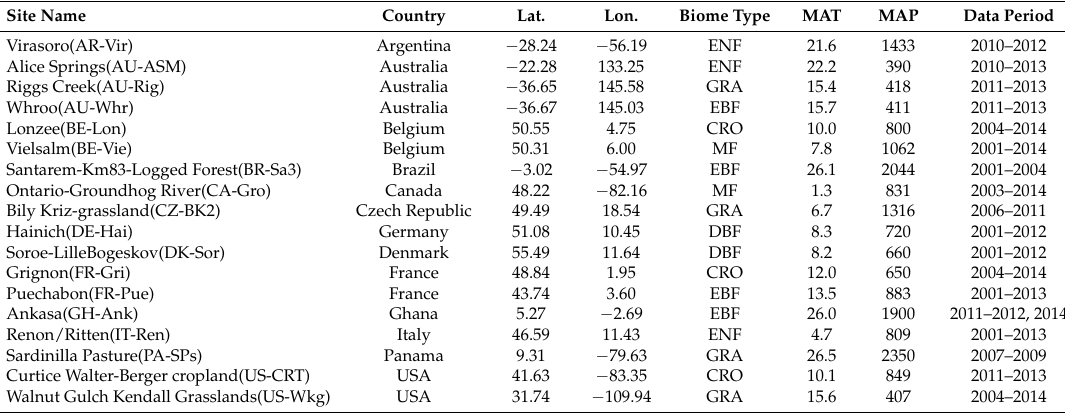
Table 1. List of FLUXNET eddy covariance tower sites used in this study. Site descriptions include name (site ID), country, latitude and longitude (lat./lon., decimal degrees), general biome type, mean annual temperature (MAT, ◦ C), mean annual long-term precipitation (MAP, mm) and years of measurements. ENF: evergreen needleleaf forests; EBF: evergreen broadleaf forests; DBF: deciduous broadleaf forests; MF: mixed forests; GRA: grasslands; CRO: